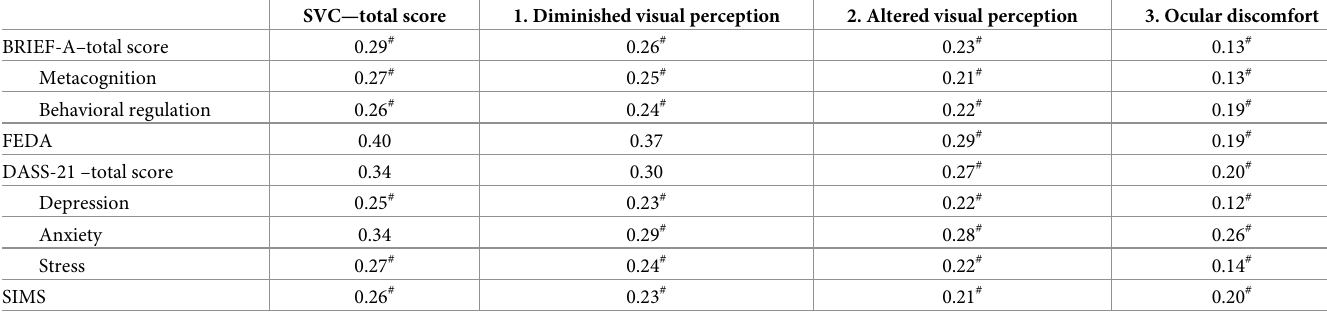
Table 5. Divergent validity of the SVC with the BRIEF-A, the FEDA, the DASS-21 and the SIMS. SVC—total